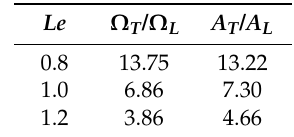
Table 3. Lewis number dependence of the normalised volume-integrated burning rate Ω T / Ω L and flame surface area A T / A L when the statistics were